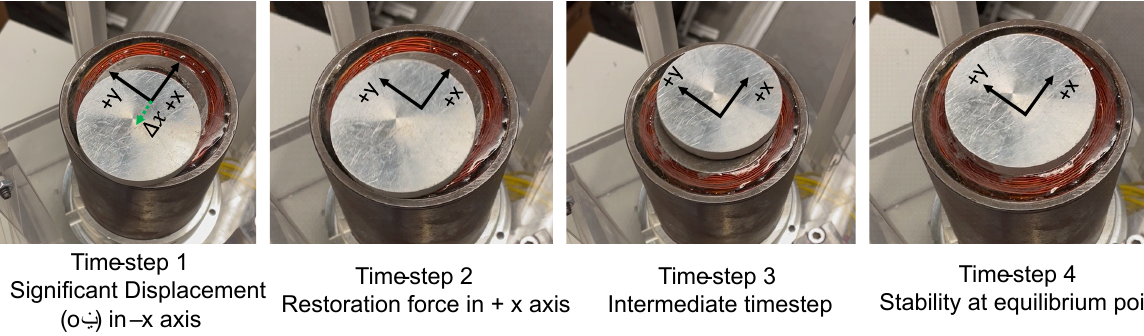
Figure 18. Stability of disc in the lateral